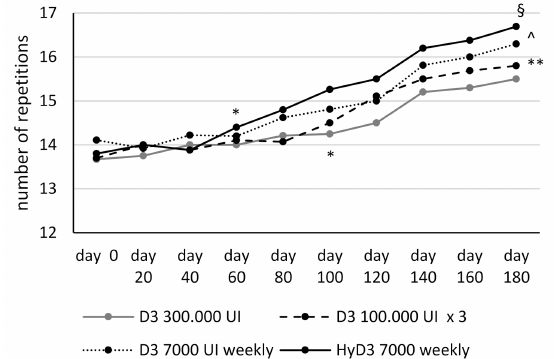
Figure 3. Sit-to-Stand test. *: p < 0.05 vs. baseline; §: p < 0.05 vs. Group 1, 2, 3; ˆ: p < 0.01 vs. Group 1, 2. **: p < 0.01 vs. Group 1. D3 = cholecalciferol; HyD3 = calcifediol. Group 1 cholecalciferol 300,000 UI single dose; Group 2 cholecalciferol 100,000 every two months; Group 3 cholecalciferol 7000 UI weekly; Group 4 calcifediol 7000 UI weekly.